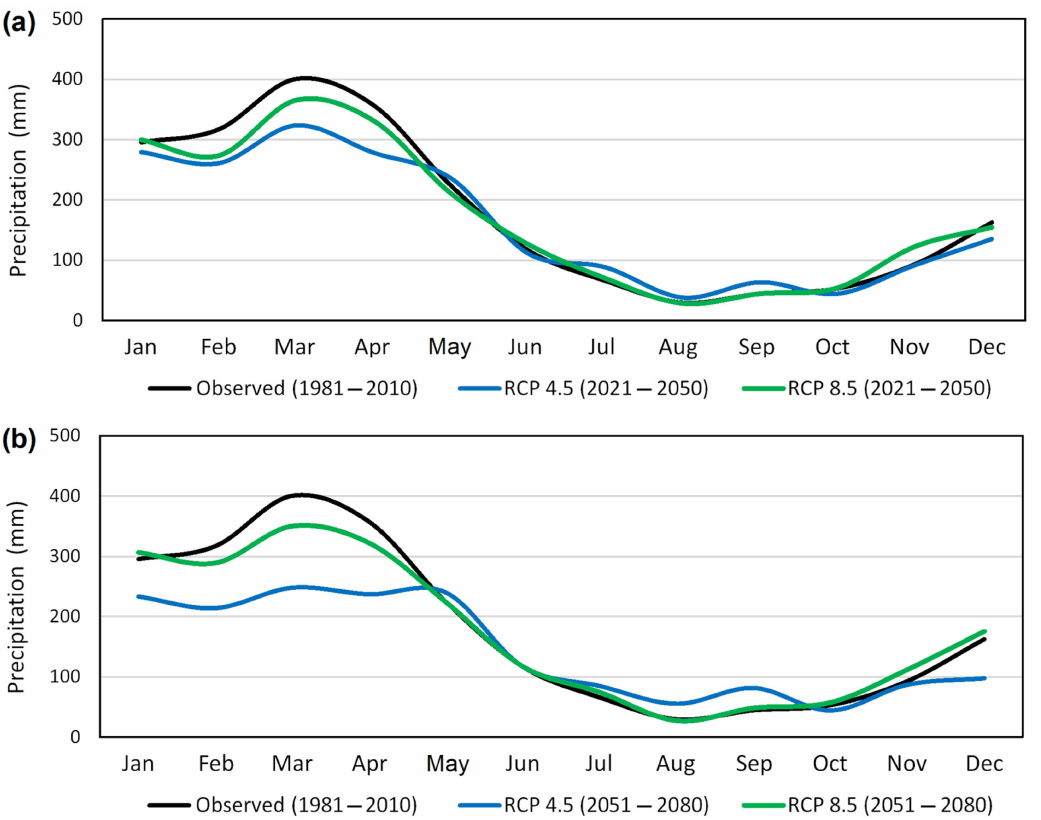
Figure 10. The monthly mean precipitation in the period of 1981–2010 (black) in Altamira and the projections for the 2021–2050 ( a ) and 2051–2080 ( b ) periods, based on the RCP 4.5 (blue) and the RCP 8.5 (green) scenarios.